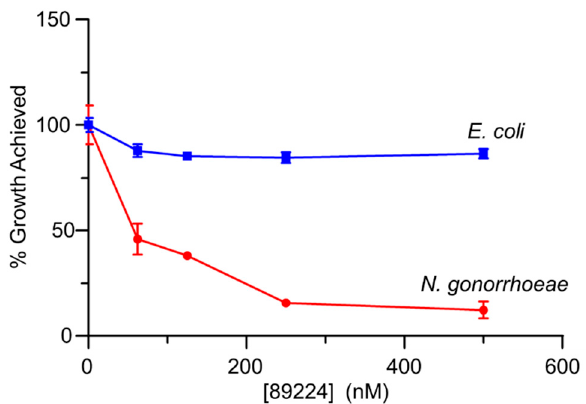
Figure 5. E ff ect of compound 89224 on growth of N. gonorrhoeae and E. coli. Cultures of the two Figure 5. Effect of compound 89224 on growth of N. gonorrhoeae and E. coli. Cultures of the bacteria in their respective liquid growth media were incubated at 37 ◦ C, with compound 89224 at the two bacteria in their respective liquid growth media were incubated at 37 ° C, with concentrations indicated, and growth was monitored at 600 nm until control cultures reached stationary compound 89224 at the concentrations indicated, and growth was monitored at 600 nm phase. The data presented represent the average extents of growth of cultures relative to the respective until control cultures reached stationary phase. The data presented represent the average control cultures. Error bars denote standard deviations ( n = extents of growth of cultures relative to the respective control cultures. Error bars denote standard deviations ( n = 3).